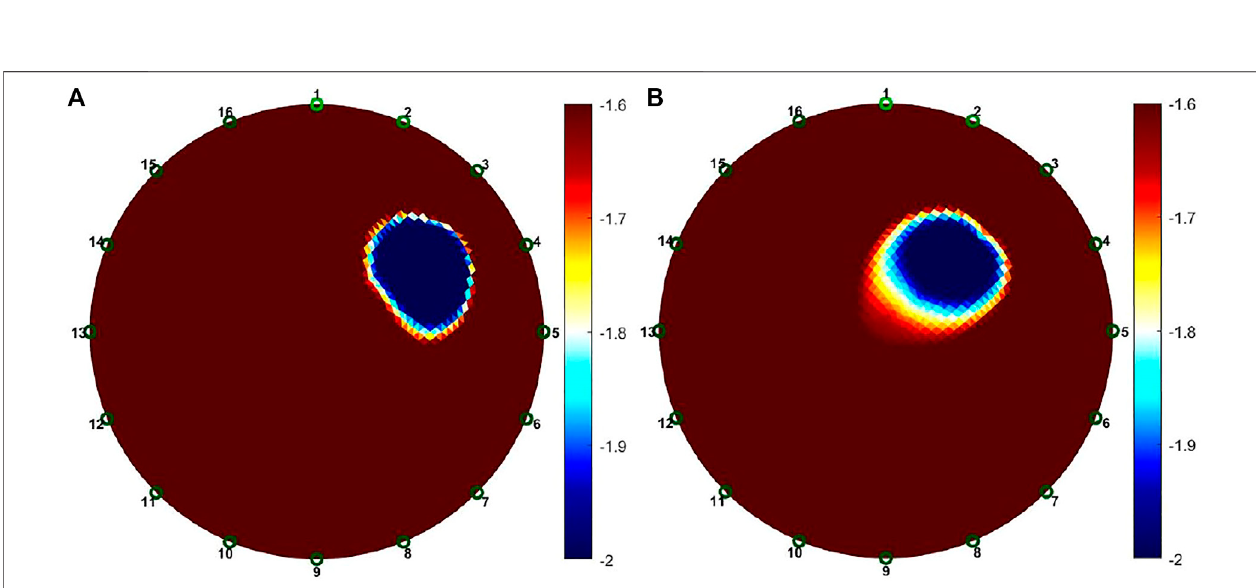
FIGURE8| Reconstructionofthesaline- fi lledphantomusingdataobtainedby (A) AM(handselection)and (B) AX (multiplexedwithnocorrection).Additionalnoise is observed in (B) . QF = 57.